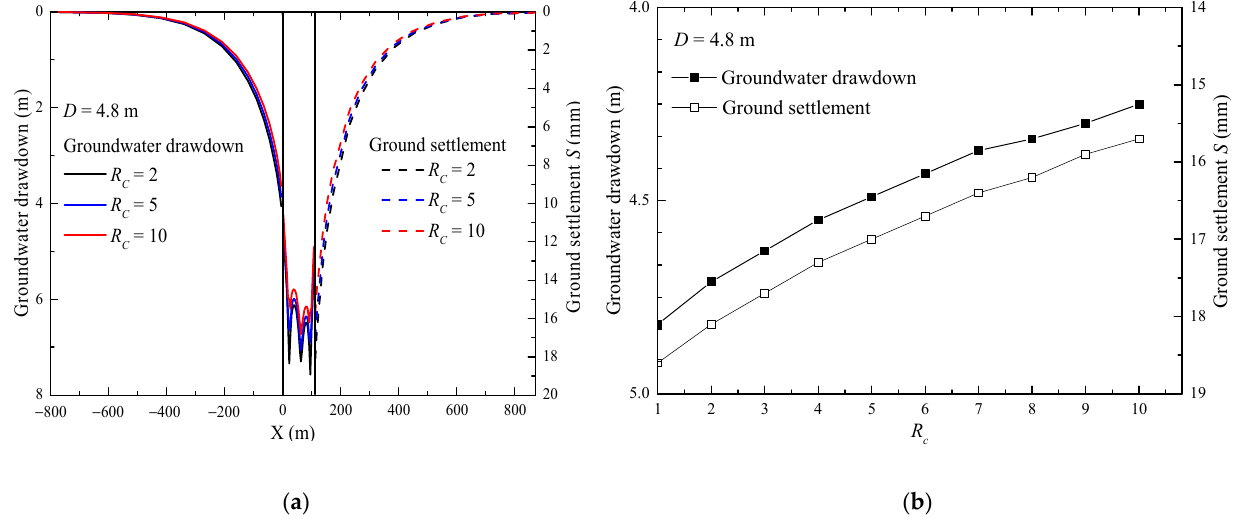
Figure 9. Groundwater drawdown and ground settlement with different value of D : ( a ) Section I-I; ( b ) Point G12.